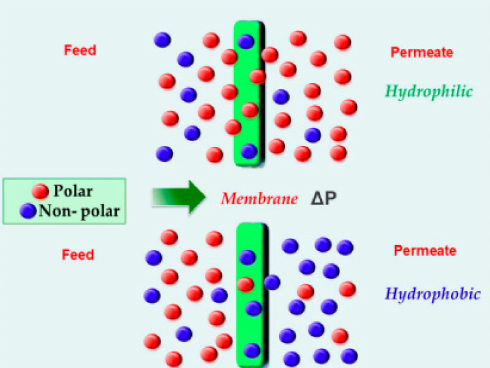
Figure 3. Preferential transport of hydrophilic and hydrophobic membranes. Adapted from [6] with permission from Copyright (2019),